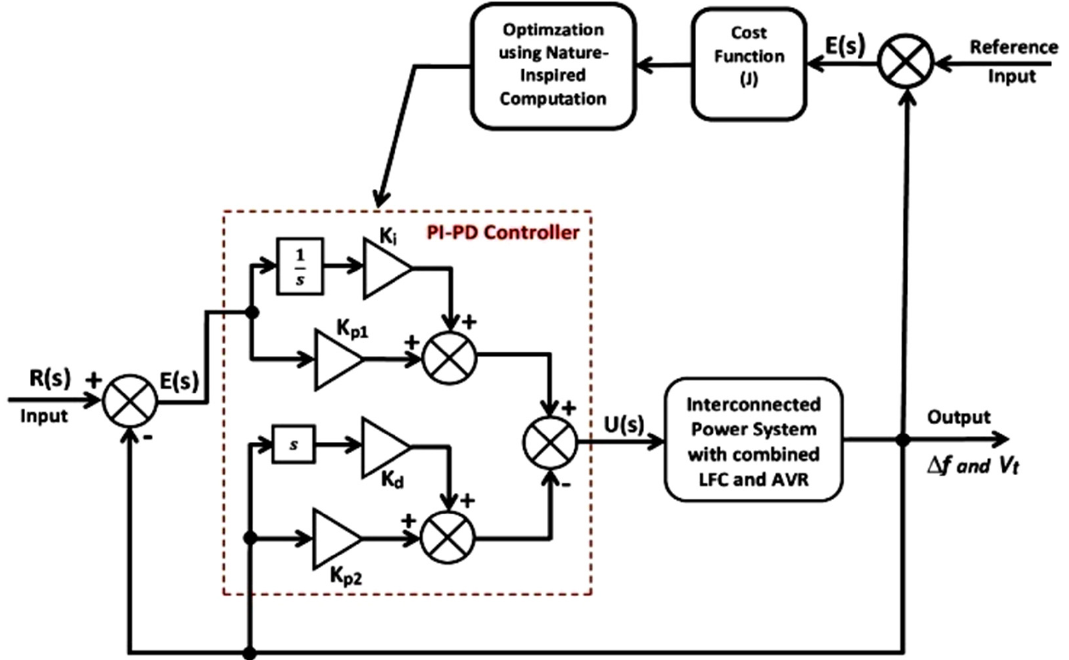
Figure 3. Proposed control scheme [4].